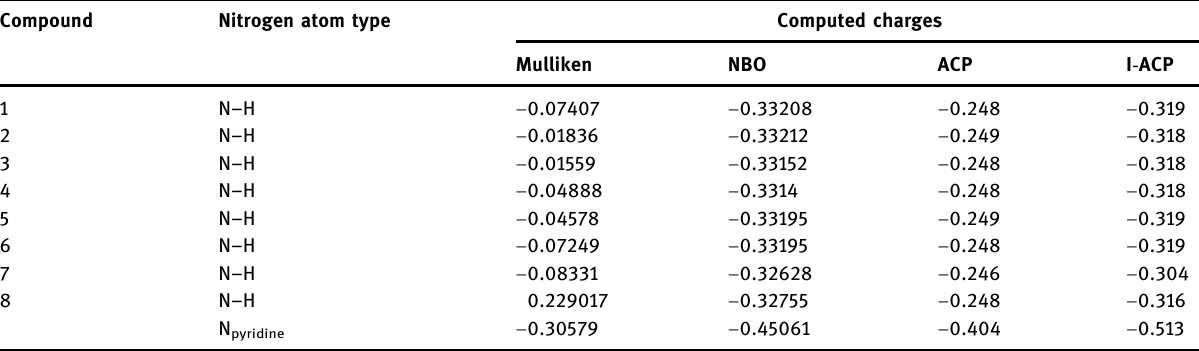
Table 1: Computed charges for di ff erent types of nitrogen atoms within the structure of investigated azoles 1 – 8 ; N pyrrole ( N – H type of atom ) , N pyridine ( pyridine - like nitrogen atom within the azole 8 moiety )